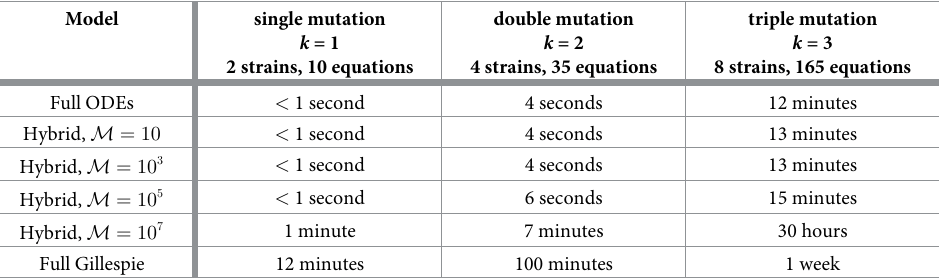
= 1 for all i ). The i